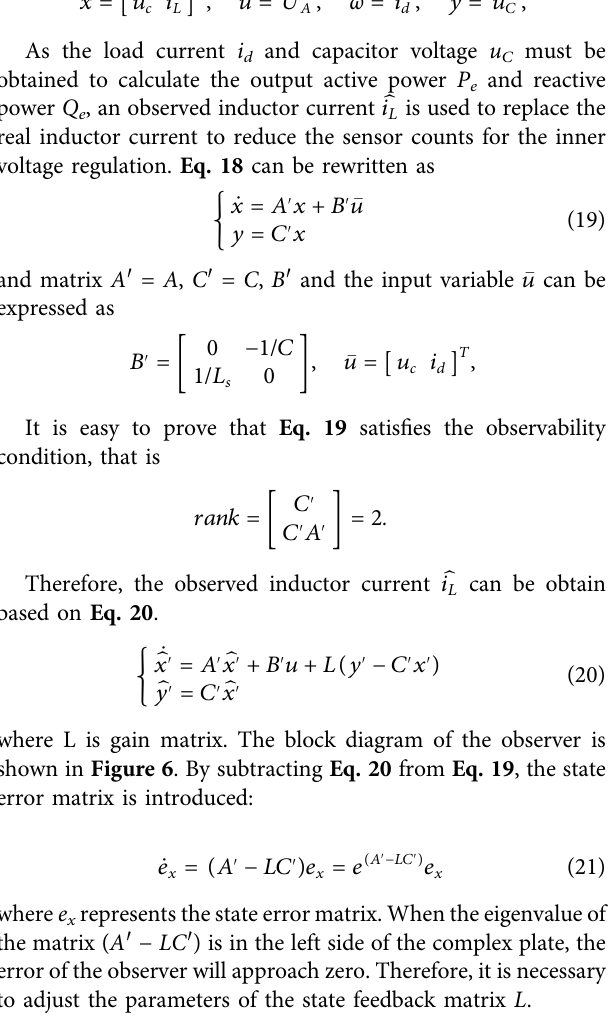
FIGURE 10 | Seamless transfer of the single-phase VSG. (A) Simulation waveform of capacitor voltage and load current in island mode. (B) Pre- synchronization process. (C) Simulation waveforms of capacitor voltage and load current from island mode to grid-connected mode. (D) Simulation waveforms of capacitor voltage and load current from grid-connected mode to island mode. (E) partial enlarged view of capacitor voltage and load current (grid-connected mode to island